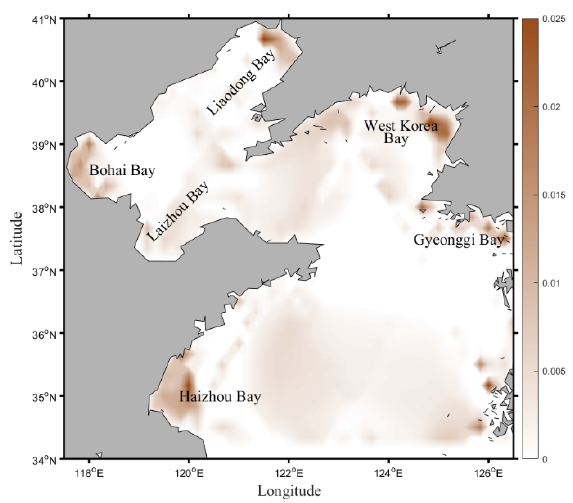
Figure 3. The distribution of estimated BFCs in the BYS.